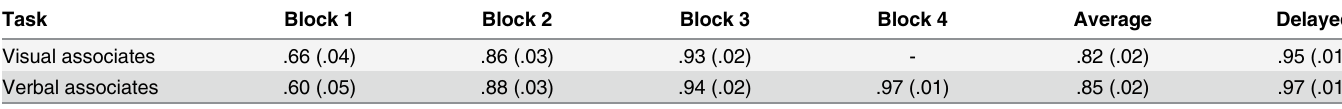
Table 4. Mean proportion of correct responses over blocks for the visual and verbal paired associates